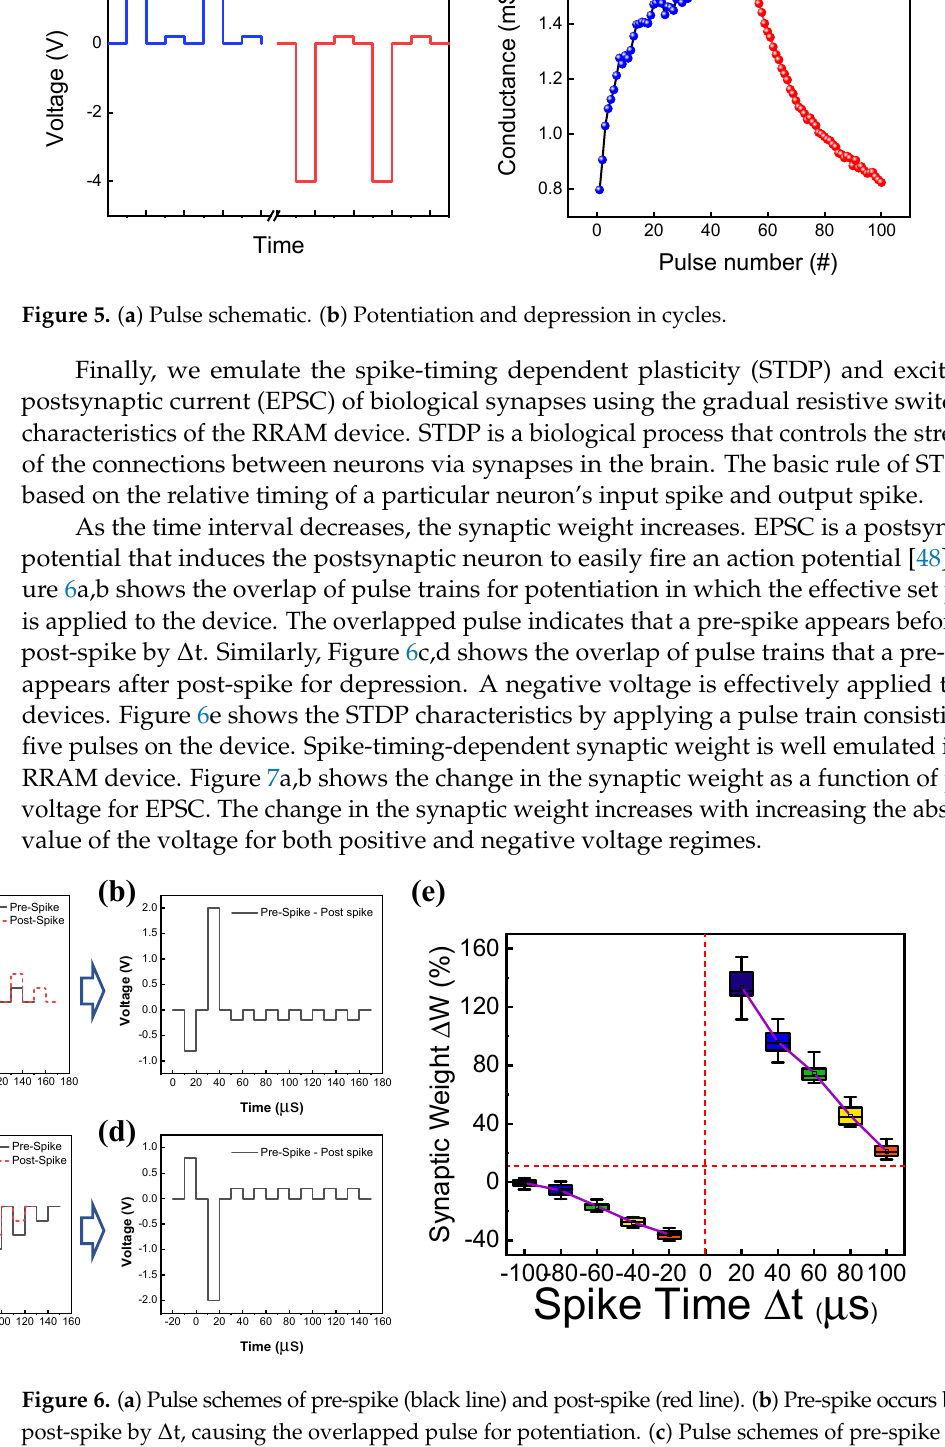
(amplitude voltage: 1.8 V, width: 100 μ s) and reset pulse (amplitude voltage: − 1.8 V, width: 100 μ s) are used for potentiation and depression, respectively.